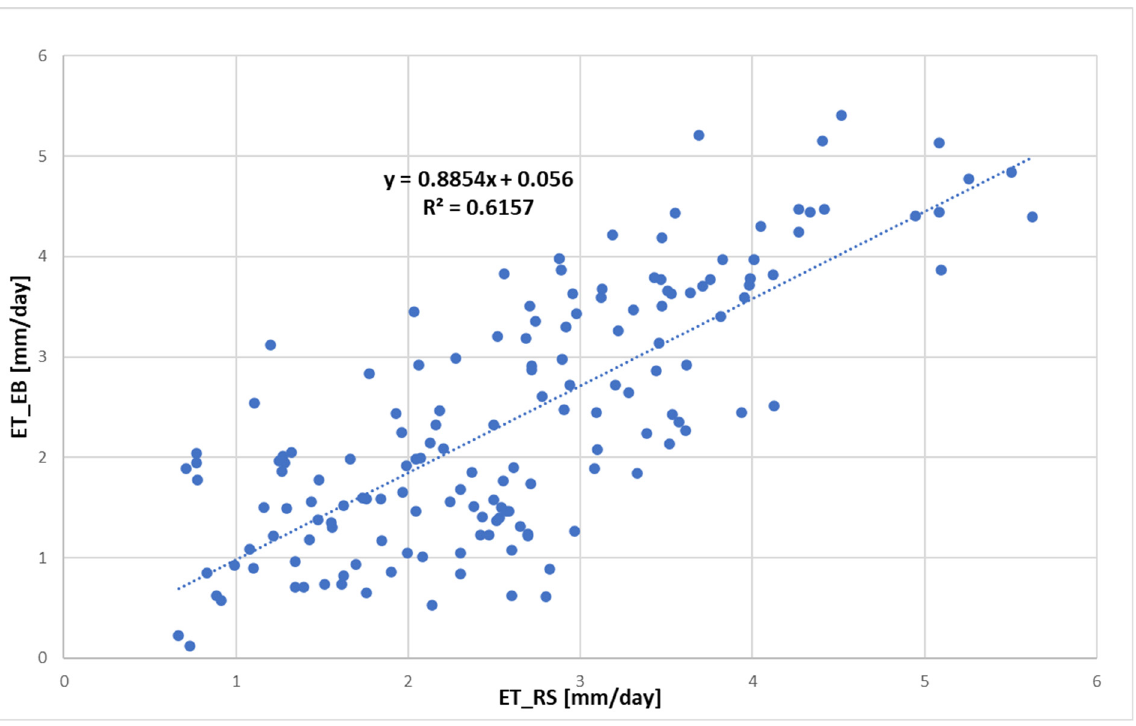
Figure 10. The correlation between ground-measured ET based on energy balance station (ET_EB) and remote-sensed ET (ET_RS).